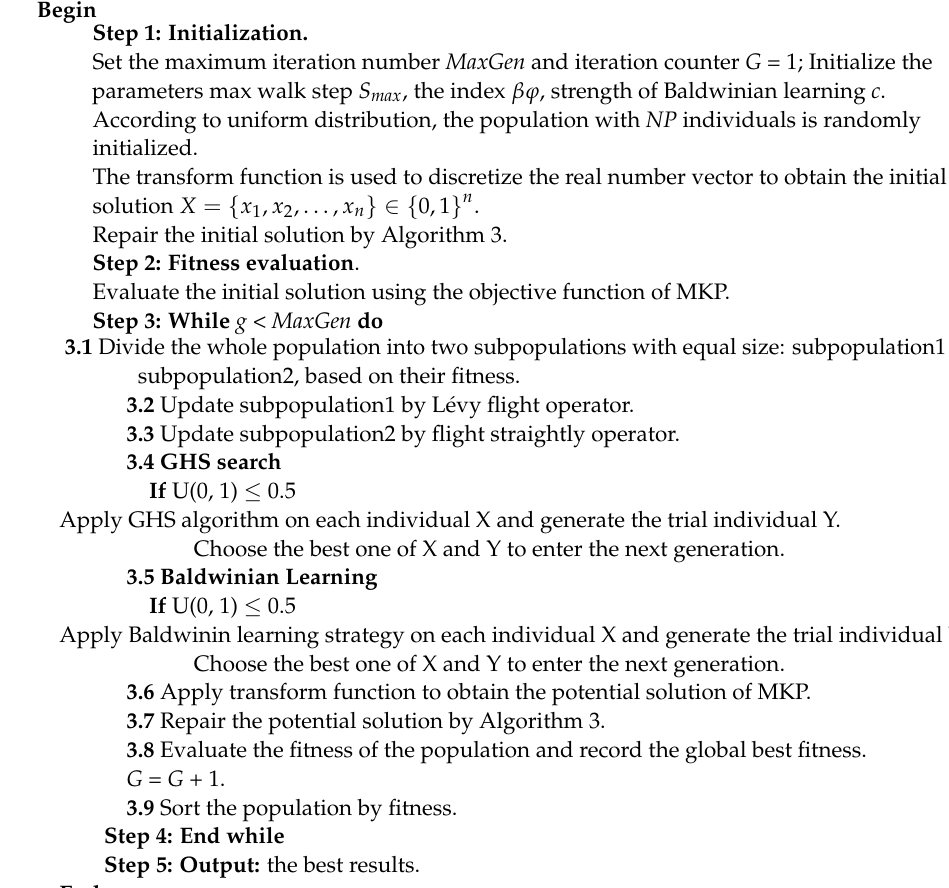
Algorithm 4. Procedure of HLMS for MKP